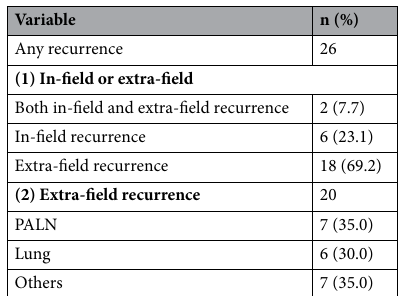
Table 2. Distribution of recurrence with regard to the radiation field. PALN para-aortic lymph node.